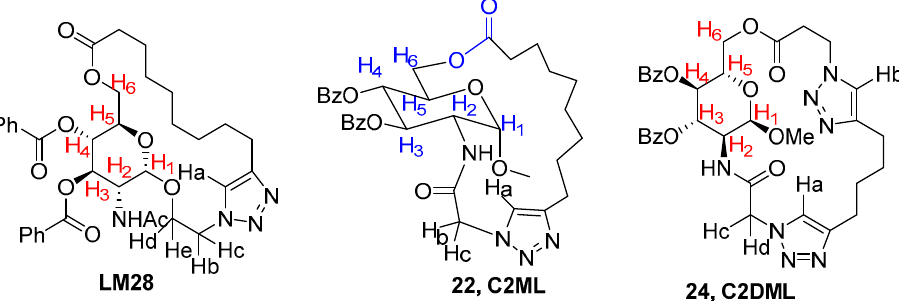
Figure 2. Structures of several macrocycles and the protons assigned. The 1 H NMR spectra of LM28 with TBACl are shown in Figures 3, S1 and S2. The triazole C-H and the amide NH signals of LM28 showed significant chemical shift changes upon adding halides. From 0 to 10.0 equiv of TBACl, the NH showed the most significant downfield shift of 0.59 ppm—this indicated strong hydrogen bonding with the chloride. The triazole signal also shifted downfield, with 2.0 equiv of TBACl, the Ha moved down- field by 0.16 ppm; interestingly, this signal only shifted another 0.04 ppm when 10.0 equiv of chloride was added. The significant downfield change of triazole and NH signals with increasing amounts of chloride indicated that they were affected by forming hydrogen bonds with chloride and by anion- π interactions. Other protons were less affected by chlo- ride additions and showed small upfield shifts. The anomeric proton shifted upfield by 0.04 ppm, H 3 by 0.05 ppm, and H 4 by 0.10 ppm. Without chloride, the Hb, Hc, and Hd are multiplets centered at δ 4.73, 4.57, and 4.39 ppm, respectively, and the Hb and Hc each showed doublet of triplet splitting pattern (dt). However, with 10.0 equiv of TBACl, the Hb and Hc merged to a pseudo triplet. These changes indicated that the chloride binding to the ring caused significant chemical and magnetic environment changes for the macro- cycle protons. The anion binding did not affect the conformation of the sugar ring much, but did change the dihedral angles of anomeric methylene groups (Figure 2). Figure 3. 1 H NMR spectra of LM28 with different amounts of TBACl from 0 to 10.0 equiv. The 1 H NMR spectra of LM28 with TBABr and TBAI are shown in Figures S3–S8; the patterns are similar to those of chloride, but with much smaller chemical shift changes. From 0 to 5.0 equiv of TBABr, the triazole signal showed about 0.10 ppm downfield shift, and the NH signal shifted downfield by 0.19 ppm, the anomeric proton showed a small upfield shift of 0.03 ppm. These results showed that the bromide also forms hydrogen